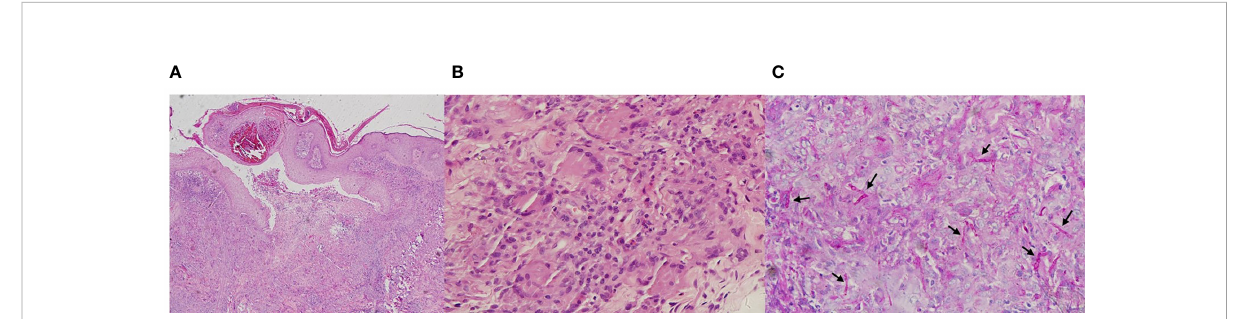
FIGURE 2 Pathological diagnosis of deep dermatophytes. (A, B) Hematoxylin and eosin staining of the deep dermatophytes revealed pseudoepitheliomatous hyperplasia; neutrophilic microabscesses, epithelioid cells, and multinucleated giant cells were observed within the dermis (Magni fi cation: A , 40×; B , 400×). (C) Periodic acid – Schiff stains showed septate fungal hyphae (black arrow) in the stratum corneum or within giant cells (Magni fi cation: